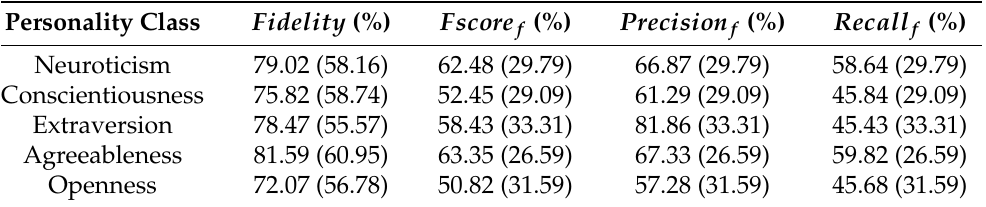
Table 3. Out-of-sample performance of rules that explain the model’s classifications. The performance of a random explanation is shown in